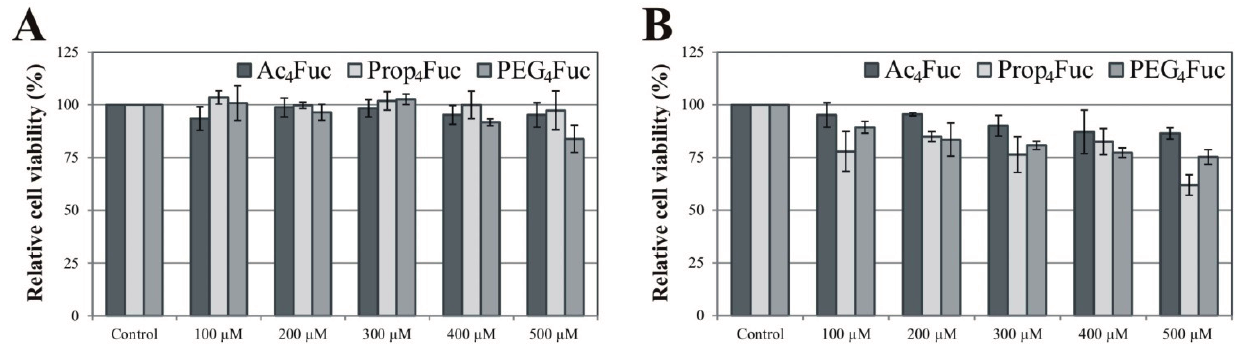
Figure 2. Viability of recombinant HEK-293T/A1AT cells measured by MTT assay subsequent to a treatment with acylated fucose analogues for three days. Culture conditions in serum-containing DMEM ( A ) are opposed to serum-free AEM ( B ). Data represent the mean ± standard deviation of quadruplicates and are related to an untreated